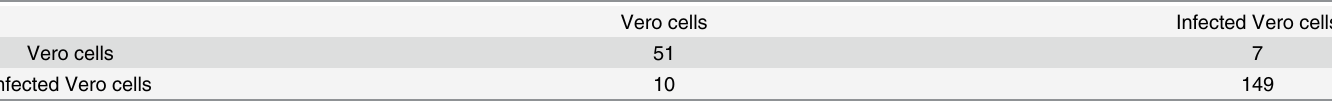
Table 2. Performances of LDA calculations for the second strategy, step 1: The calculations were performed in order to differentiate between two classes, control Vero cells and infected Vero cells. The infected Vero cells category includes HSV-1 infected Vero cells, HSV-2 infected Vero cells and VZV infected Vero cells, and uses 13 PCs.